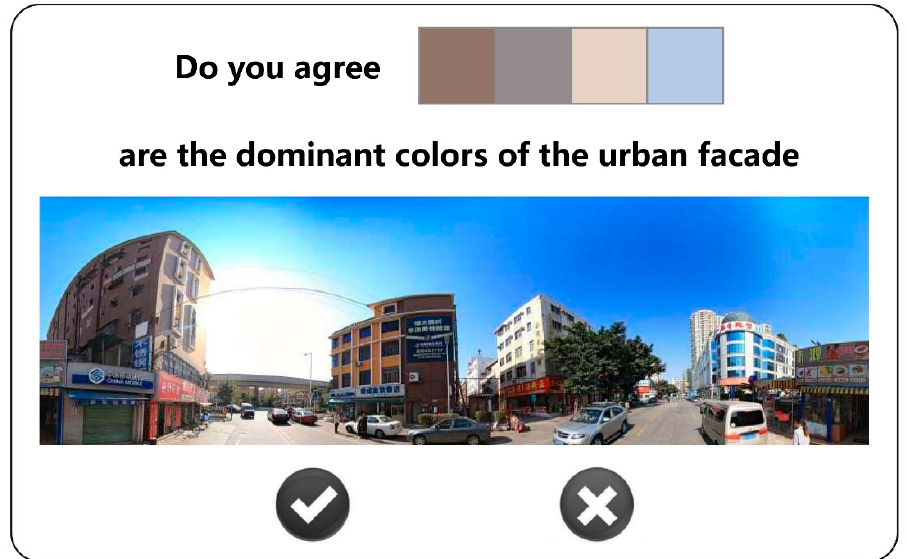
Figure 10. The user interface of the software developed for results